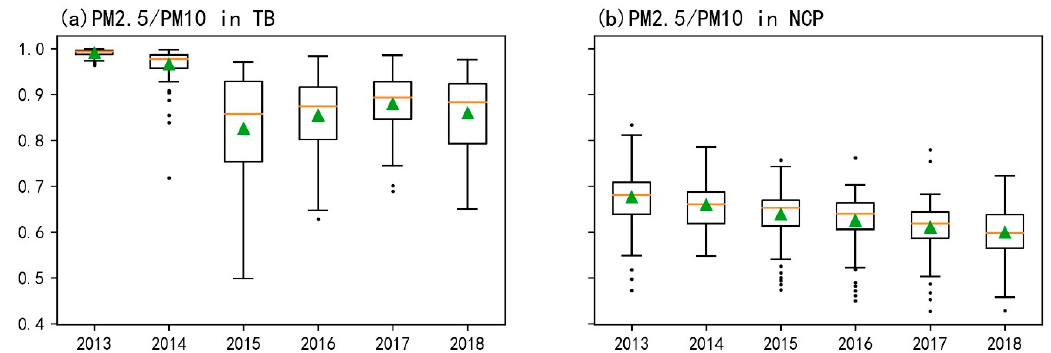
Figure 6. Interannual variation in the ratio of the PM 2.5 to PM 10 concentration in the Tarim Basin ( a ) and the North China Plain ( b ) in summer from 2013 to 2018 (orange lines represent the median, green triangles represent the mean value and black dots represent the discrete point).